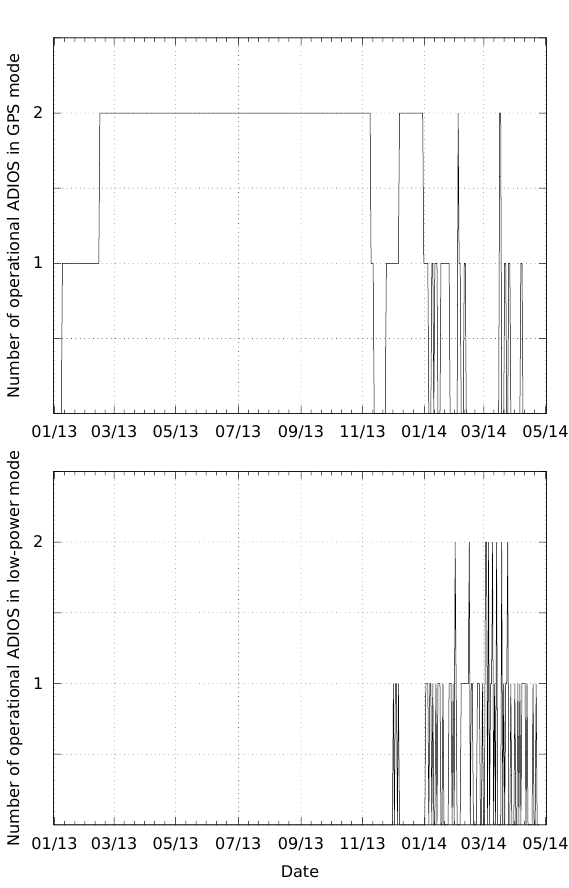
Figure 8. Operational performance of the two ADIOS iceberg tracker units located on iceberg B-31, which calved from the Pine Island Ice Shelf in November 2013.